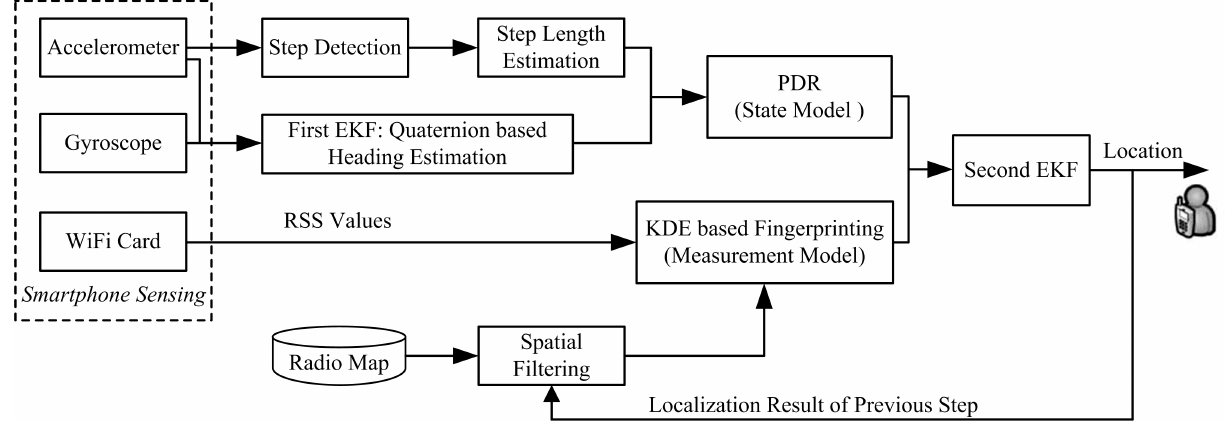
Figure 1. Architecture of the proposed extended Kalman filter (EKF) based fusion